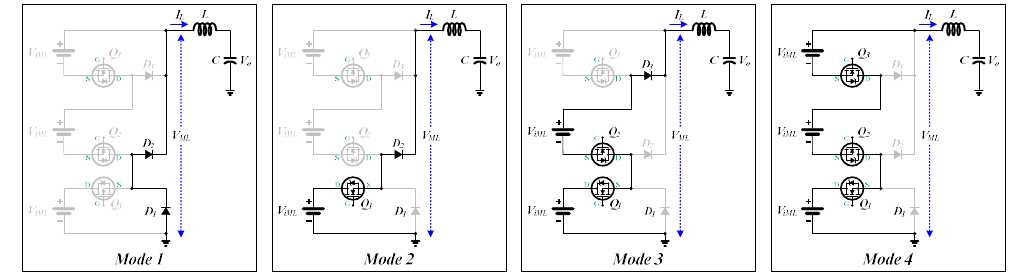
Figure 5. Operational state of DPS-MLC according to the switching state.